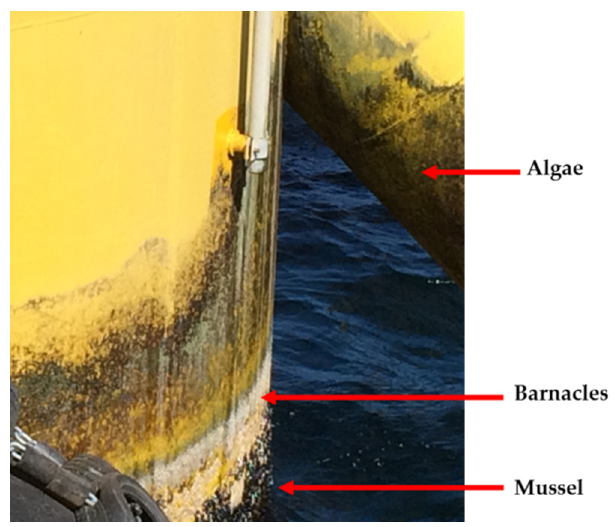
Figure 2. Floating OWS with encrustation of hard-shelled fouling organisms. Courtesy of PPI, Principle Power Inc. (Emeryville, CA, USA).